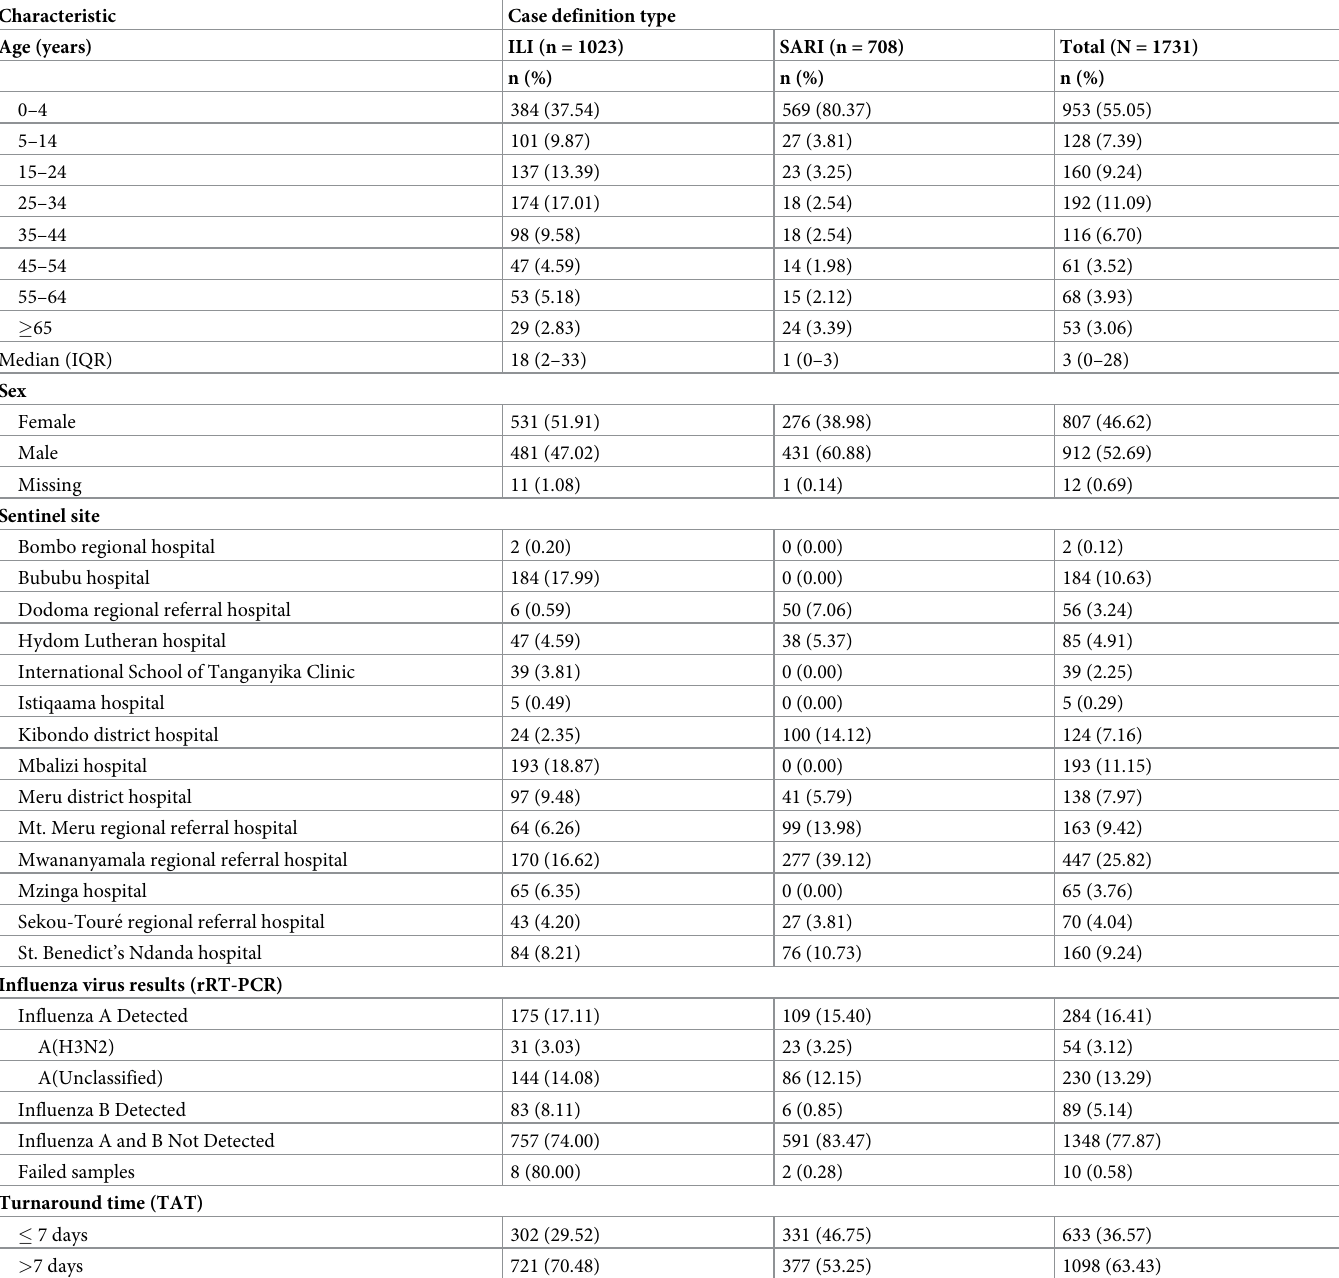
Table 1. Socio-demographic characteristics of the people under the National Influenza Sentinel Surveillance System in Tanzania, 2019. Characteristic Case definition